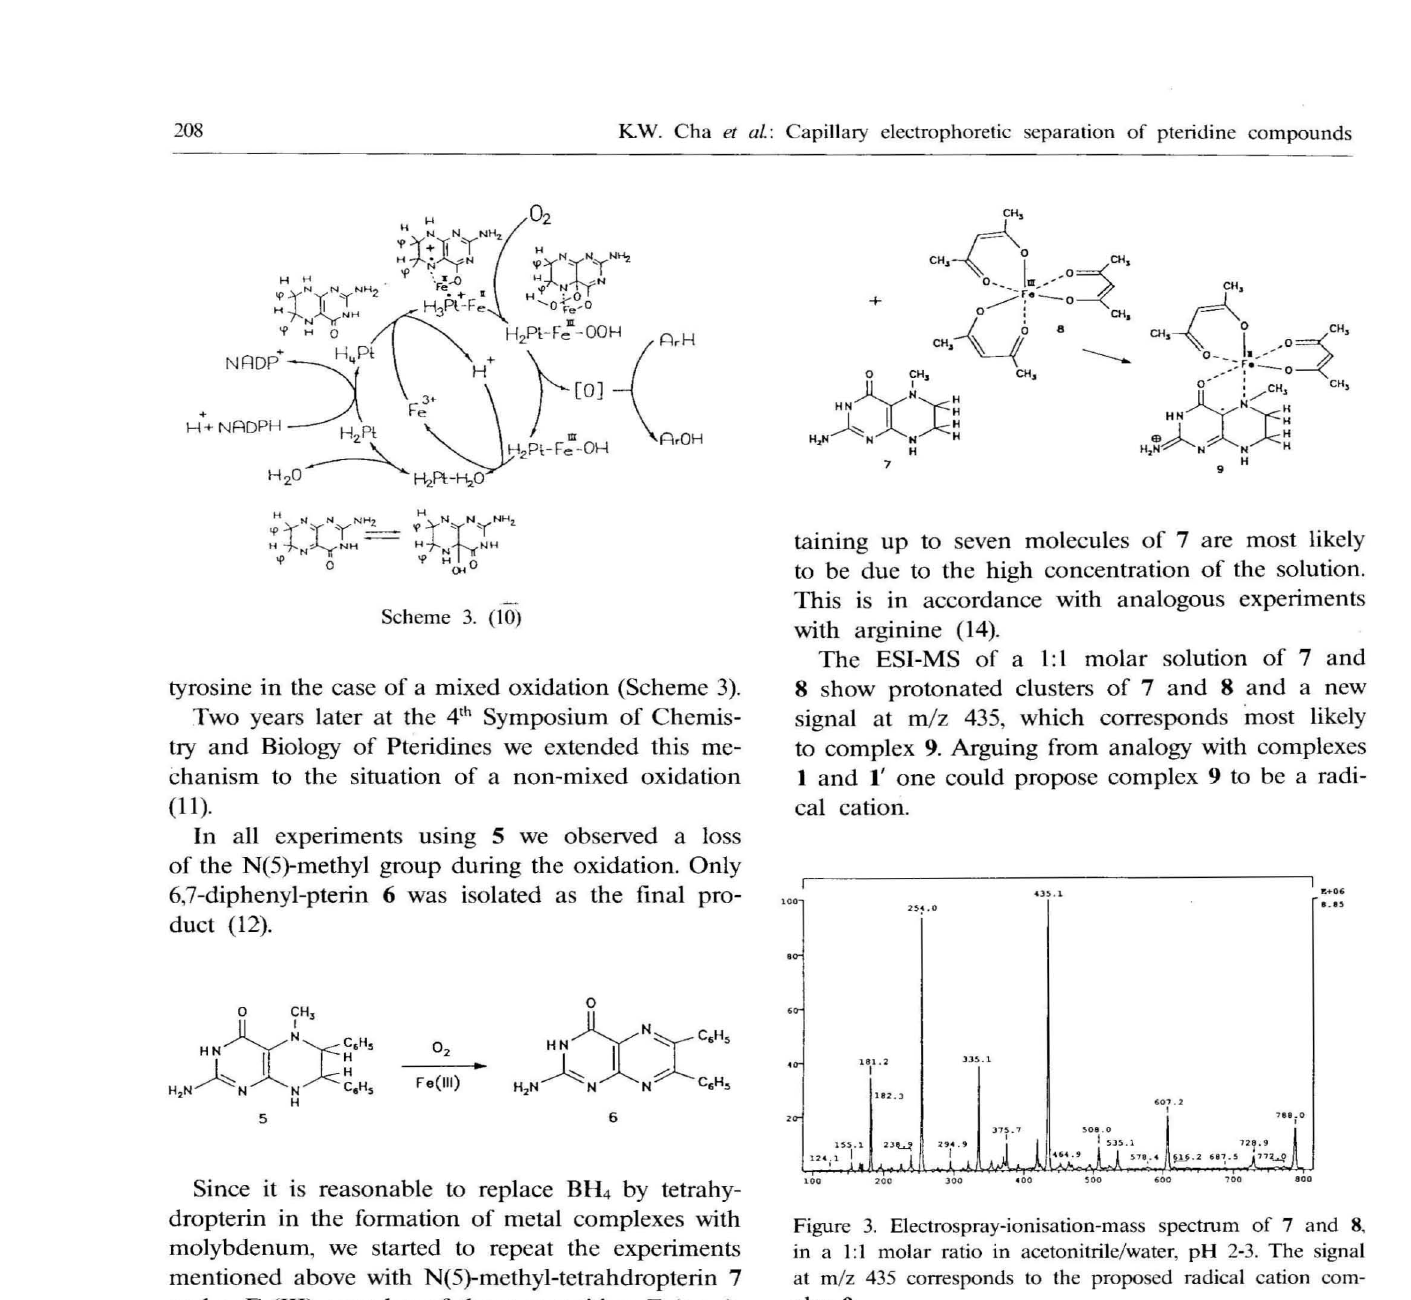
Figure 3. Electrospray-ionisation-mass spectrum of 7 and 8,